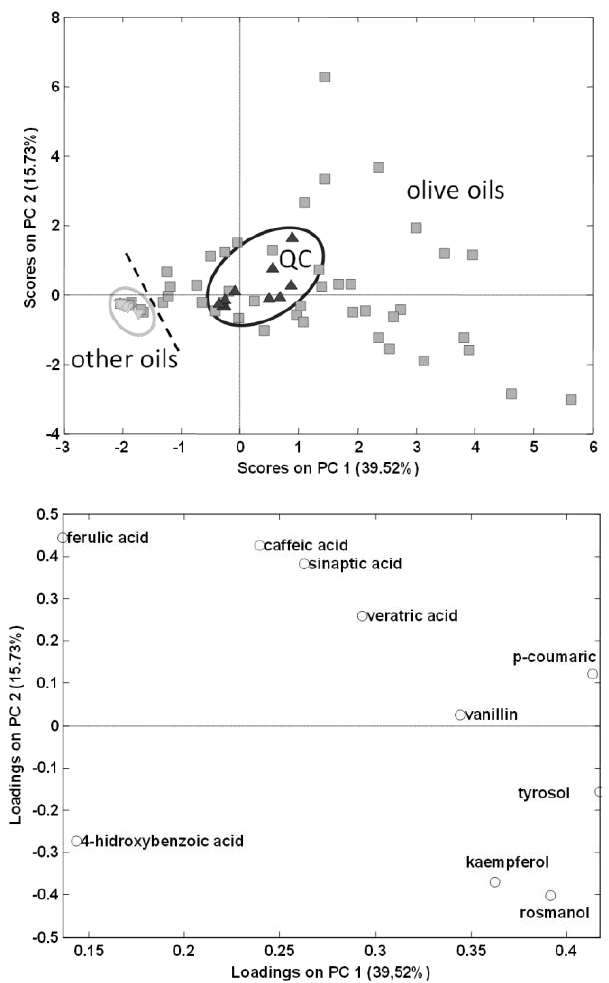
Figure 3. Principal component analysis (PCA) results (score and loading plots of PC1 vs. PC2) using as analytical data the normalized peak areas of the fourteen targeted polyphenols and phenolic acids found in the analysed vegetable oils. olive oils, other vegetable oils, and quality controls.